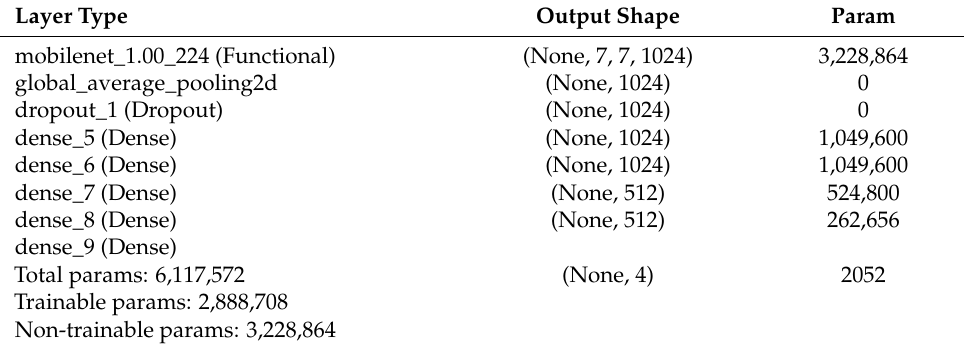
Table 3. MobileNet Fine Tuning summary.